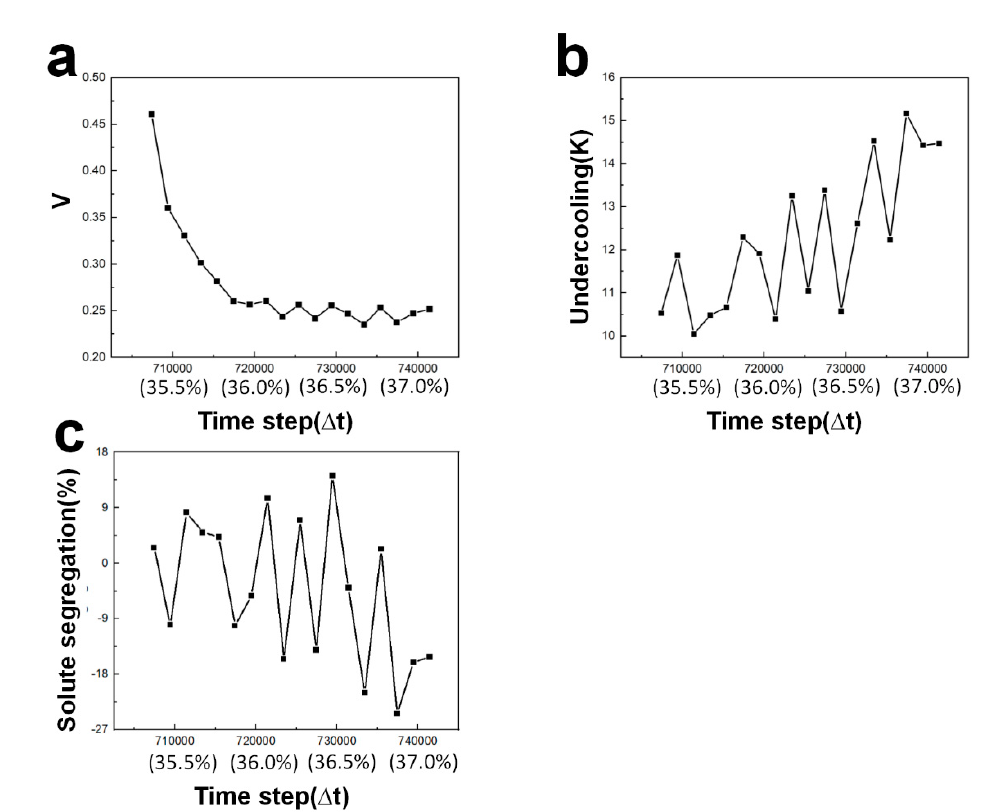
Figure 18. The evolution of ( a ) dendrite tip velocity; ( b ) undercooling; ( c ) segregation.